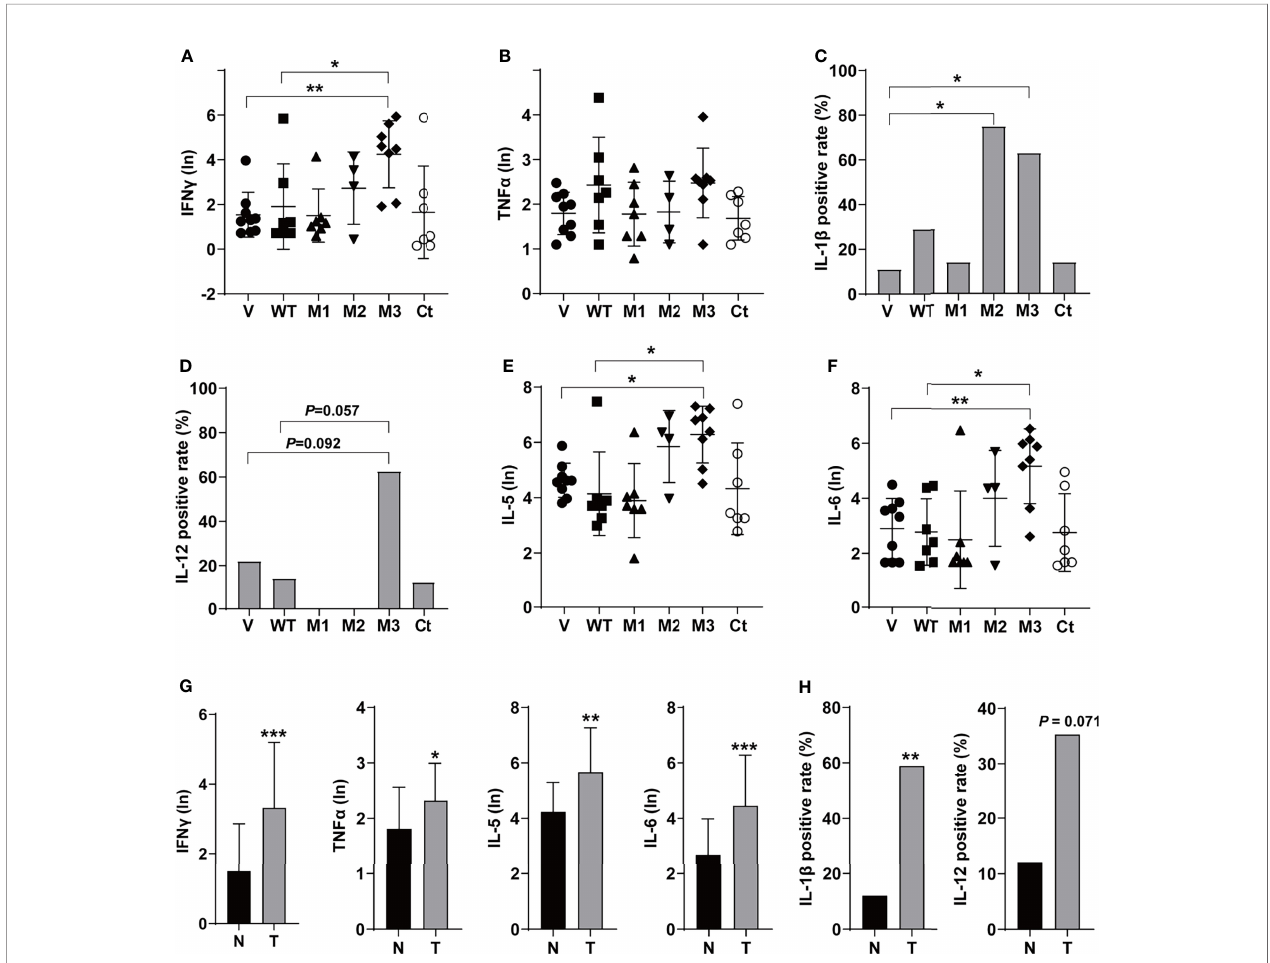
FIGURE 3 | The serum levels and the positive rates of cytokines in the SB mouse models. (A) The serum level of IFN- g ; (B) the serum level of TNF- a ; (C) the positive rate of IL-1 b ; (D) the positive rate of IL-12; (E) the serum level of IL-5; (F) the serum level of IL-6; (G) the serum levels of IFN- g , TNF- a , IL-5, and IL-6 in the mouse models with or without tumor; and (H) the positive rates of IL-1 b and IL-12 in the mouse models with or without tumor. N, the tumor-free mice; T, the mice with tumors. * P < 0.05; ** P < 0.01; *** P <